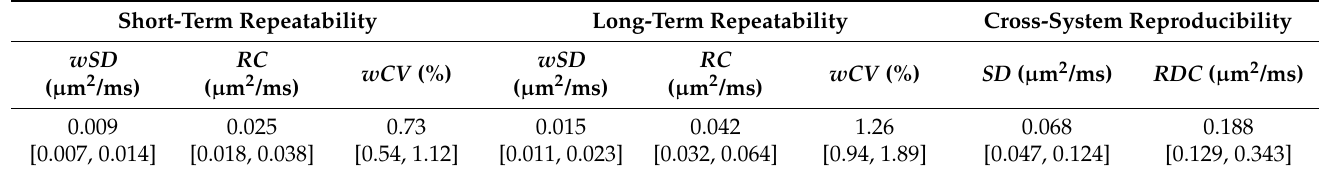
Table 2. Summary of isocenter ADC statistics across all systems with [95% confidence